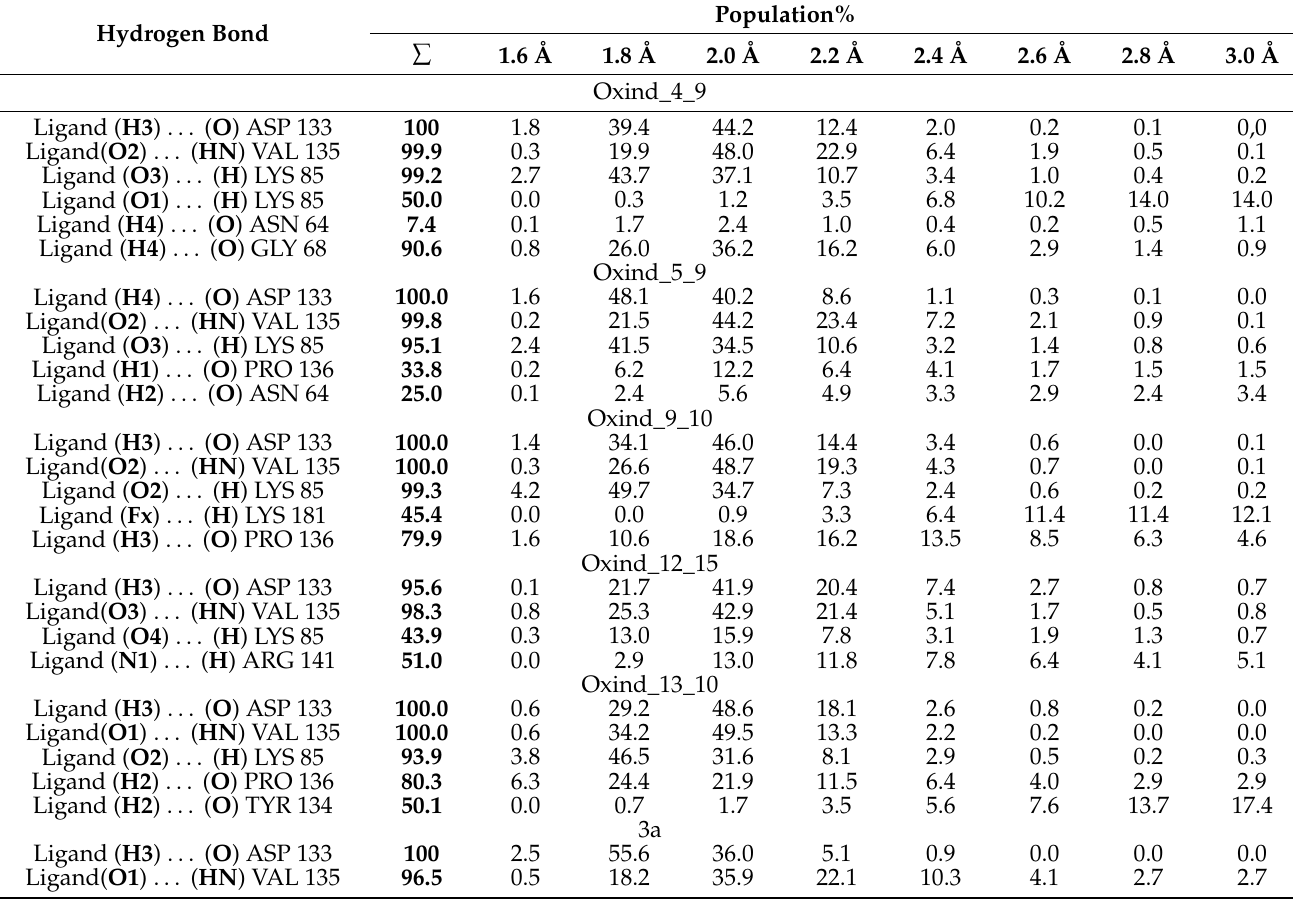
Table 4. Distribution of the most frequently created hydrogen bonds between ligand molecules and selected amino acids from the GSK-3 β active site. The hydrogen bonds in the table represent middle values of intervals with a width of 0.2 Å. Hydrogen Bond